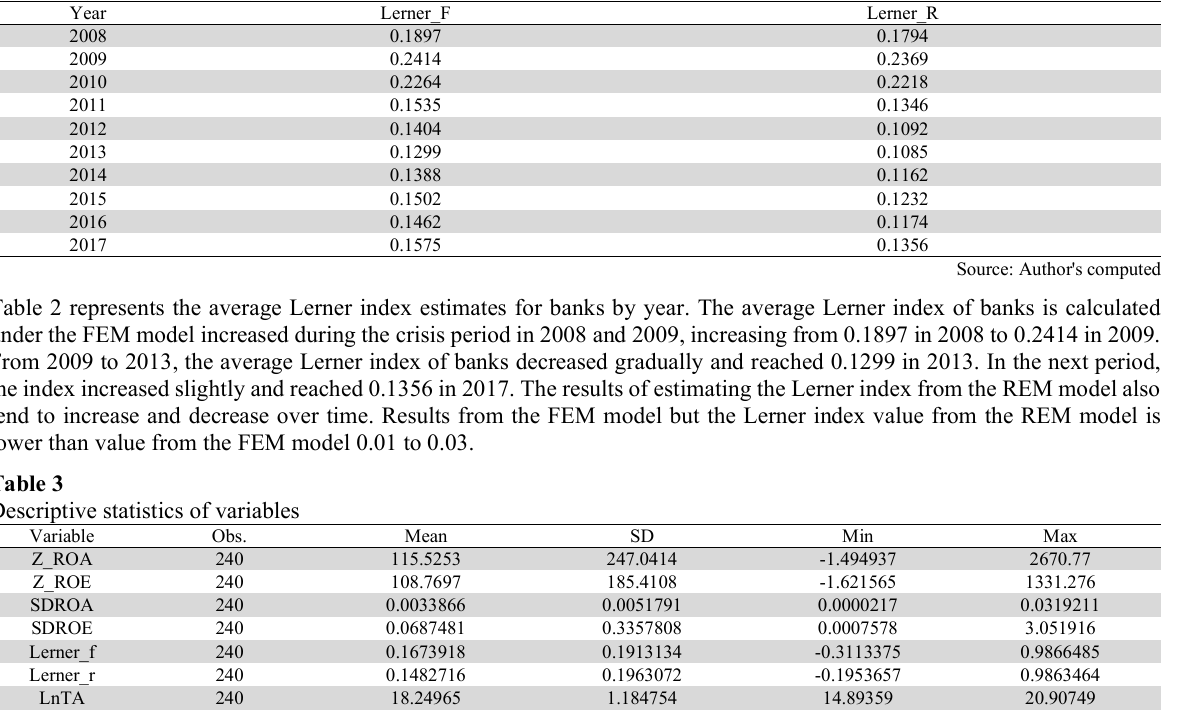
The average Lerner index by year